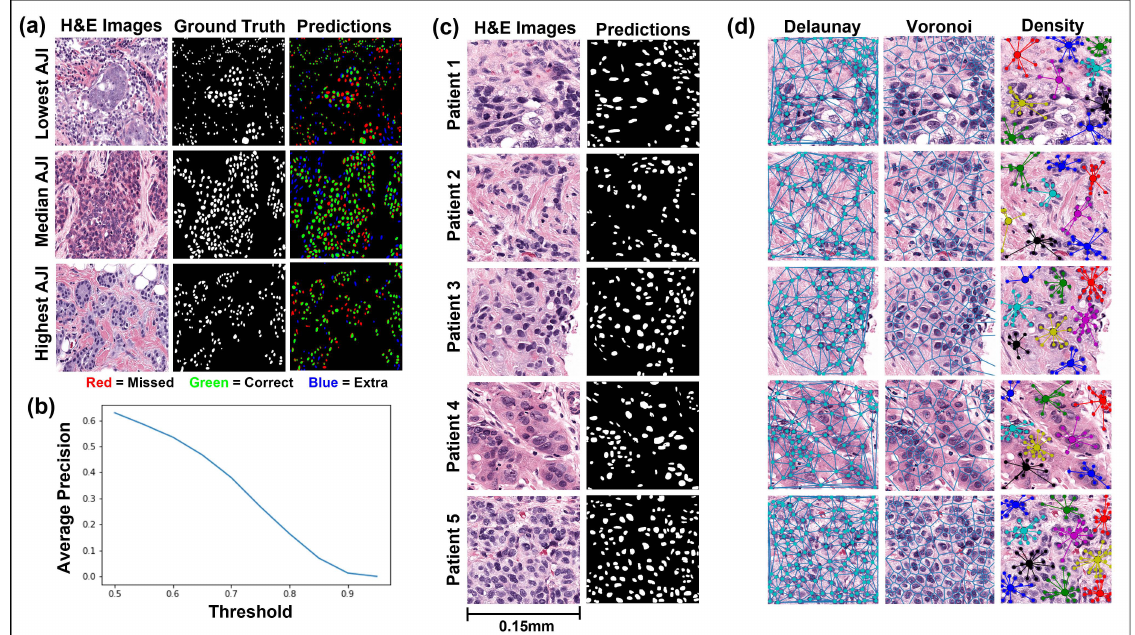
Figure 2. Instance segmentation of malignant nuclei by Mask regional convolutional neural network (Mask R-CNN) and representative feature extraction. ( a , b ) Mask R-CNN performance, evaluated on the hold-out (test) set. The highest, median, and lowest scoring AJI images from the Post-NAT-BRCA dataset are displayed. The predicted cells are color-coded such that green denotes true-positive, blue false-positive, and red false-negative pixels. Average precision over ten intersections over union thresholds is also displayed. ( c ) Representative H&E images from five patients and their respective malignant nuclei masks are displayed. ( d ) The Delaunay triangulation features, Voronoi diagram features, and density features were calculated using the centroids of the segmented malignant nuclei. Abbreviations: H&E, hematoxylin and eosin; AJI, Aggregated Jaccard